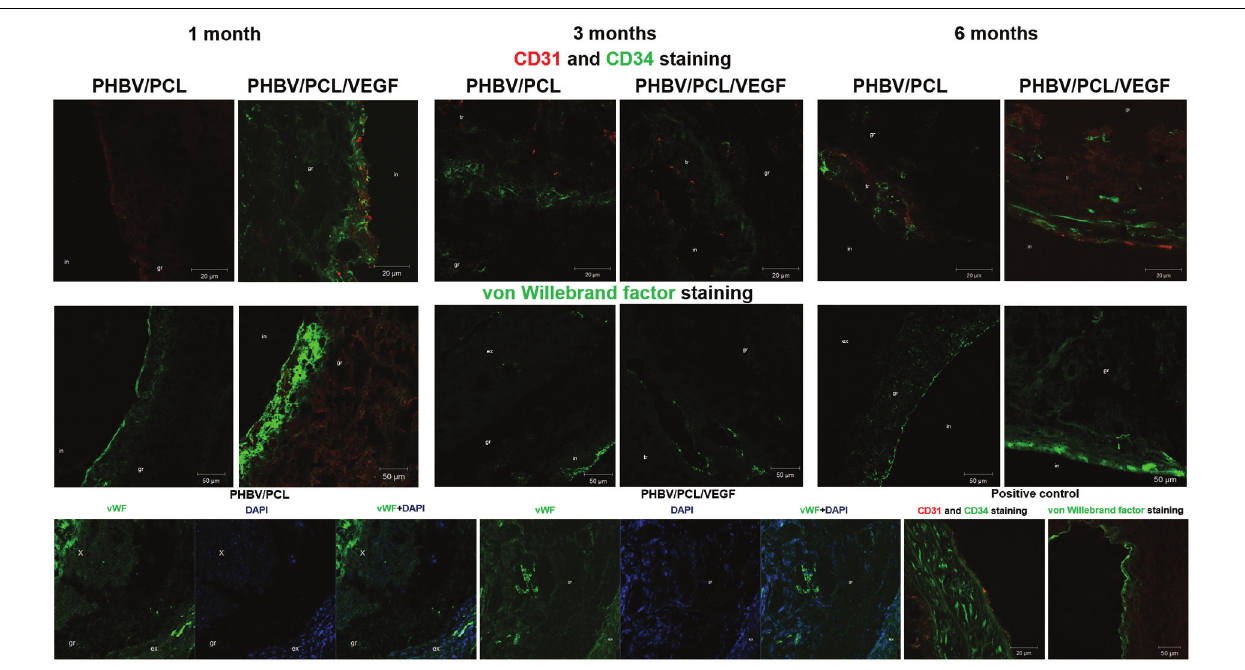
Frontiers in Pharmacology |